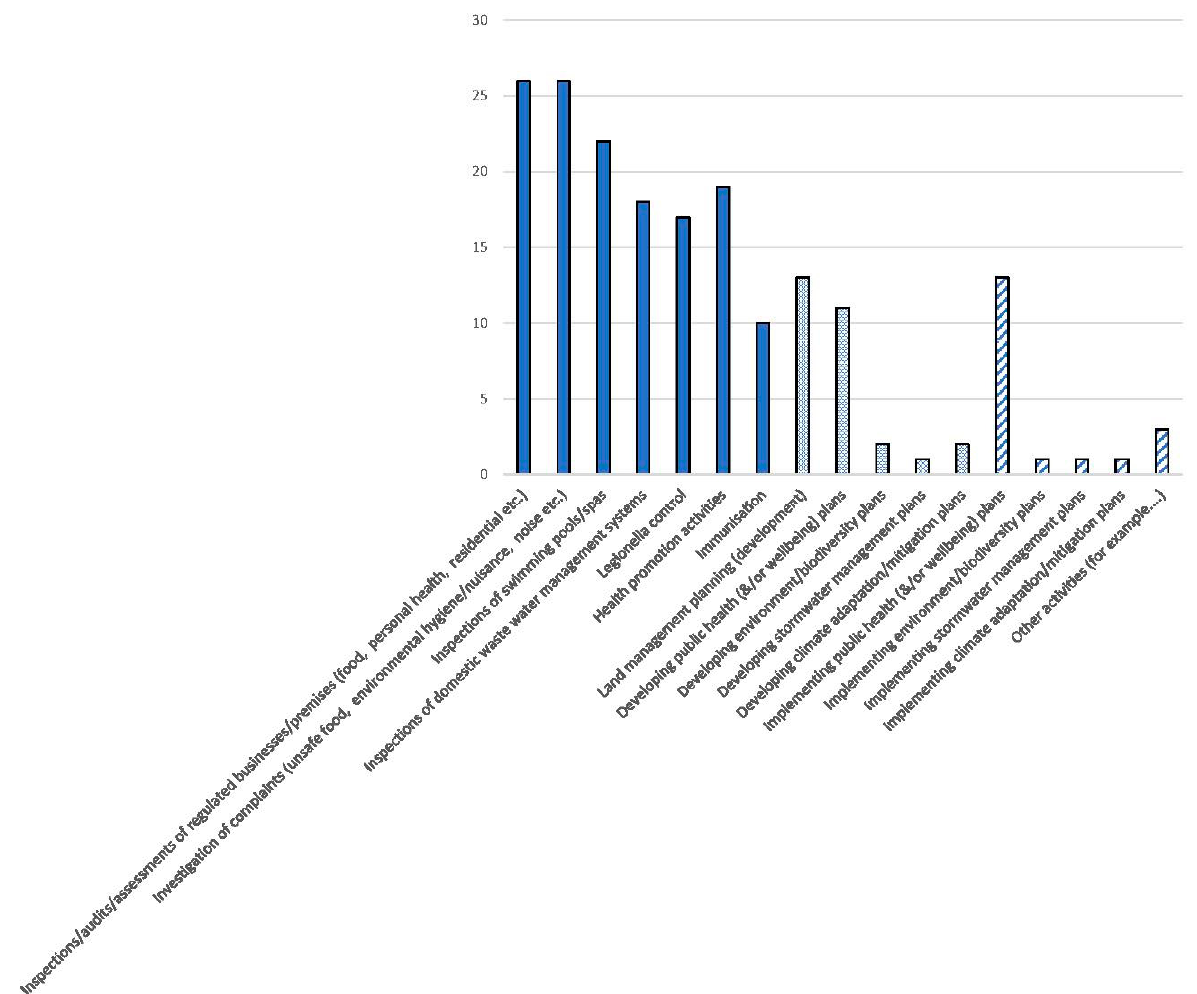
Figure 1. Main activities of EHOs identified by their executives ( n = 28) (regulatory activities = solid fill, planning = cross-hatched, and implementation = hatched lines).